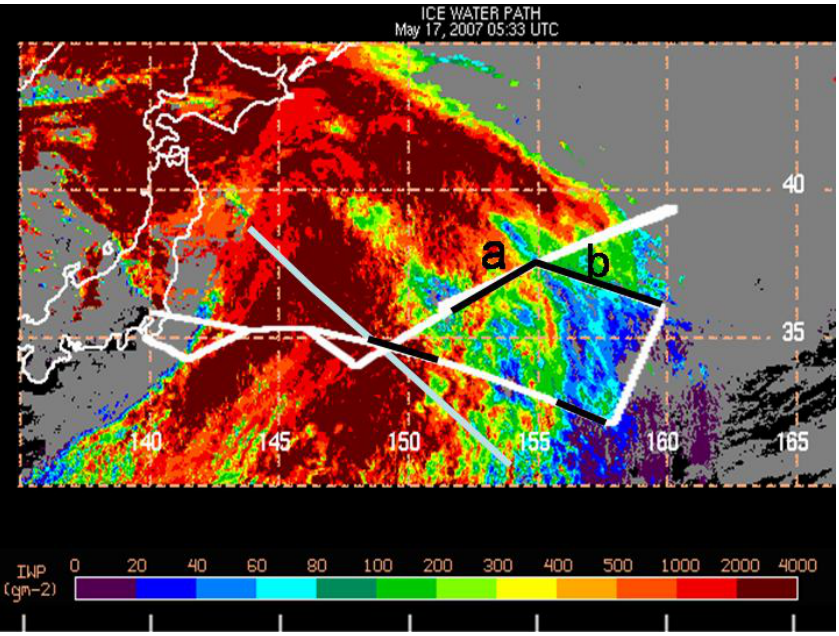
Fig. 1. Flight track of the G-V (white line) overlaid on the ice water path satellite measurements at 05:33. The light blue line represents the approximate location of the near-surface warm front, based on an encounter with it at 08:19 at 2.1km altitude. The black segments refer to sampling periods discussed in the text. Image courtesy of NASA Langley Research